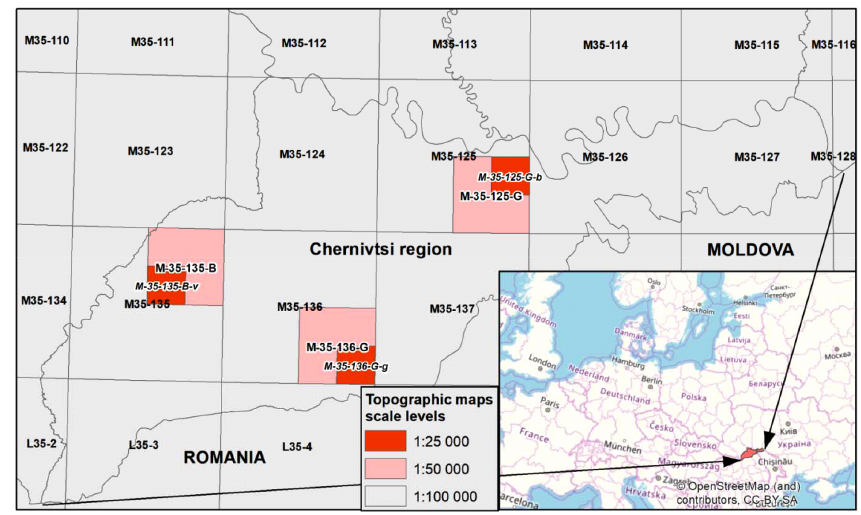
Fig. 1. The scheme of the investigated territory within the nomenclature sheets of topographic maps of different scales